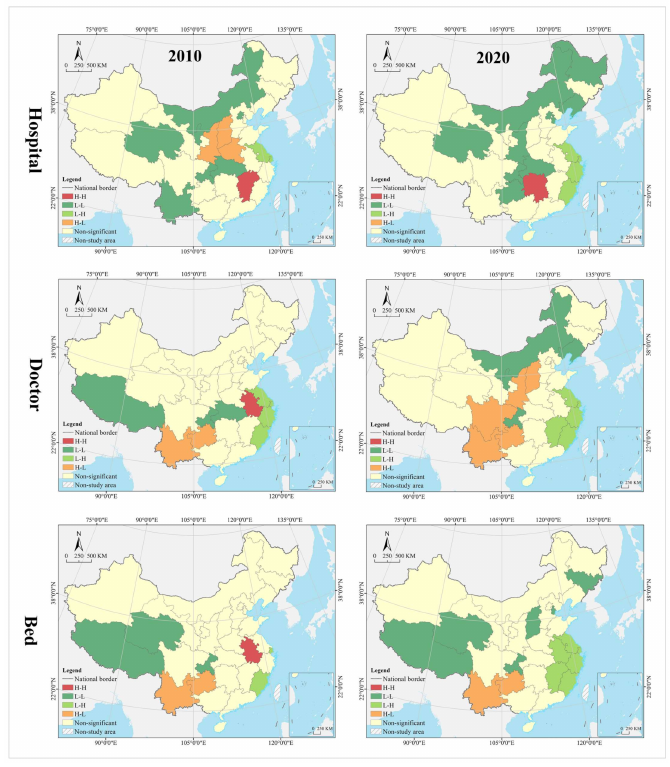
Figure 13. Spatial autocorrelation analysis of mismatch type for